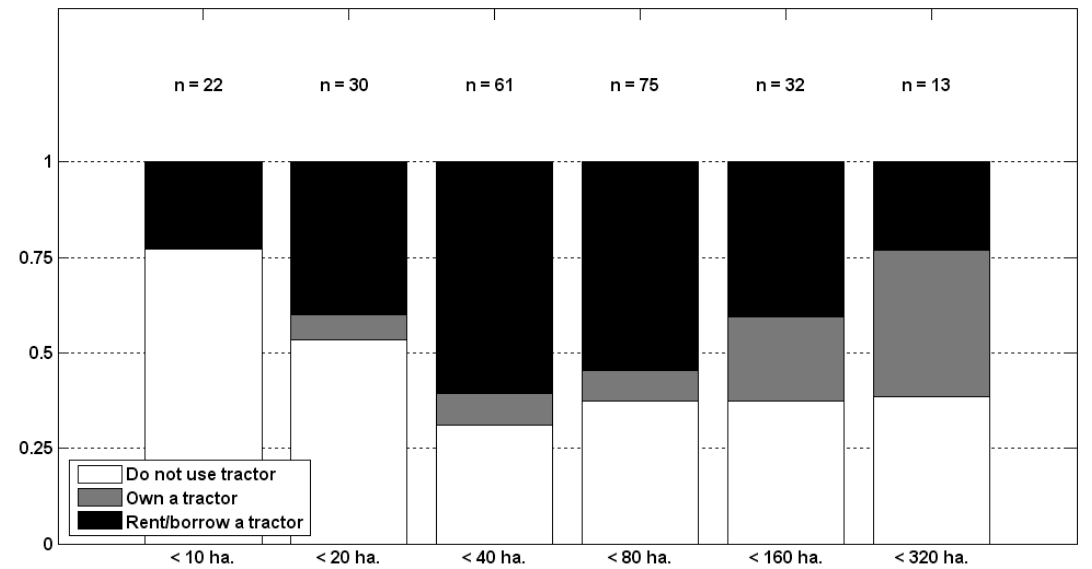
Figure A1.3: Use and ownership of tractors by survey respondents as an indicator of mechanization. The n for each bar represents the number of properties of that size in the